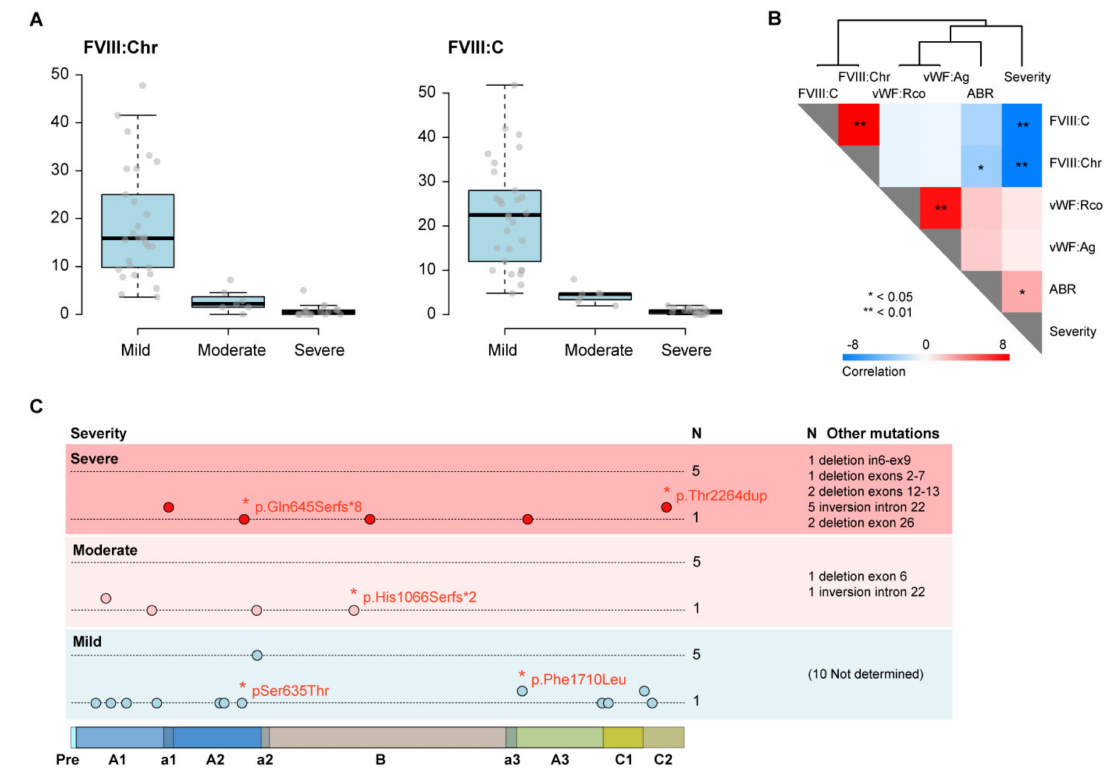
Figure 2. Characterization of the Hemophilia A cohort. ( A ) Box plots depicting the FVIII activity levels at diagnosis, as measured by FVIII:Chr (left) and FVIII:C (right) assays in mild, moderate, and severe HA patients. ( B ) Correlation analysis of FVIII activity levels (measured using FVIII:Chr and FVIII:C assays), VWF:Ag (antigenic Von Willebrand Factor levels), VWF:RCo (Von Willebrand Factor ristocetin cofactor activity), severity, and annual bleeding rate (ABR preTGT) in HA patients. Grades of blue represent inverse correlation and grades of red represent direct correlation. The level of significance is indicated with asterisks (Spearman correlation, bilateral significance). ( C ) Schematic representation of FVIII mutations and variants across the FVIII precursor sequence, as identified in the entire HA cohort, separated by severity. The new variants are indicated in red. No mutations were identified in 10 mild HA patients. The number of patients bearing a given mutation is represented (scale n = 1–5). In, intron; ex,